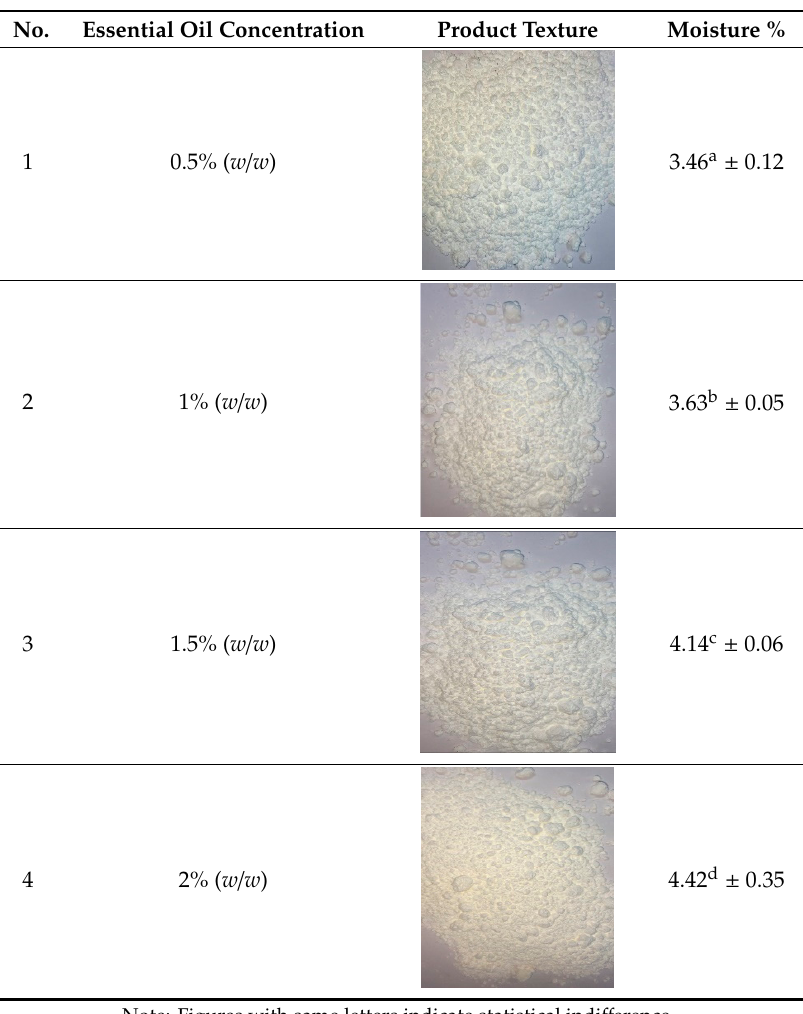
Table 4. Moisture content and texture of microencapsulation powder produced at different core materials concentrations.